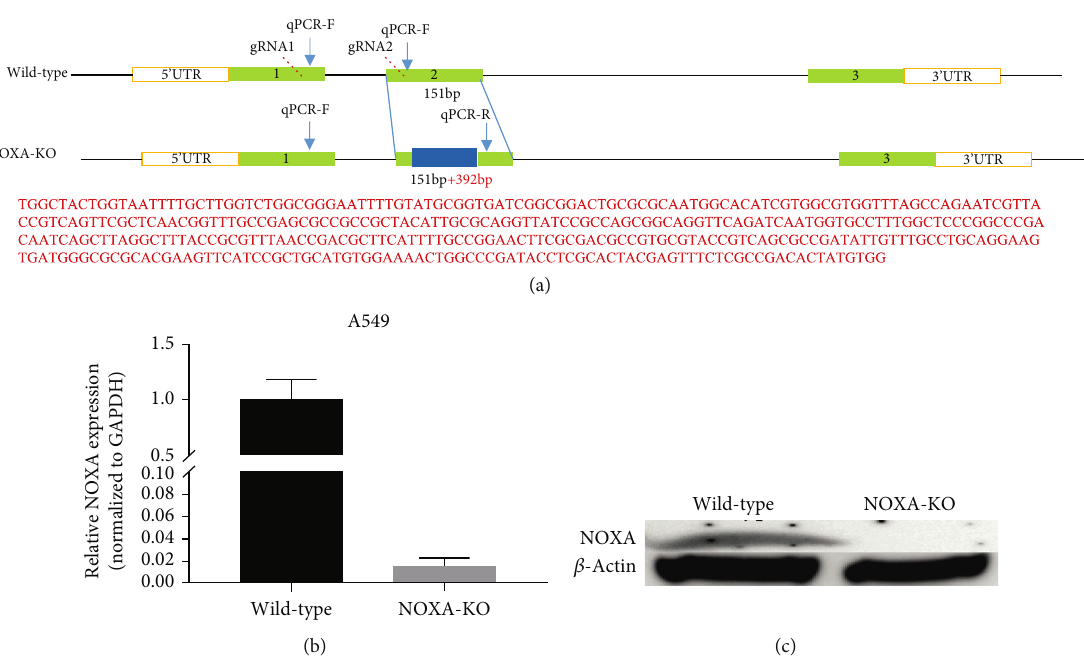
Figure 1: CRISPR/Cas9-mediated Noxa-knockout cells were generated and identi fi ed. (a) Schematic of gRNAs targeting Noxa. Sanger sequence showed a 392bp inset in exon2. (b) Noxa mRNA expression was detected via qPCR analysis. The location of qPCR primers is shown. (c) Western blotting results showing that there is no expression in mutant A549 cells with Noxa gRNAs, comparing with wild- type